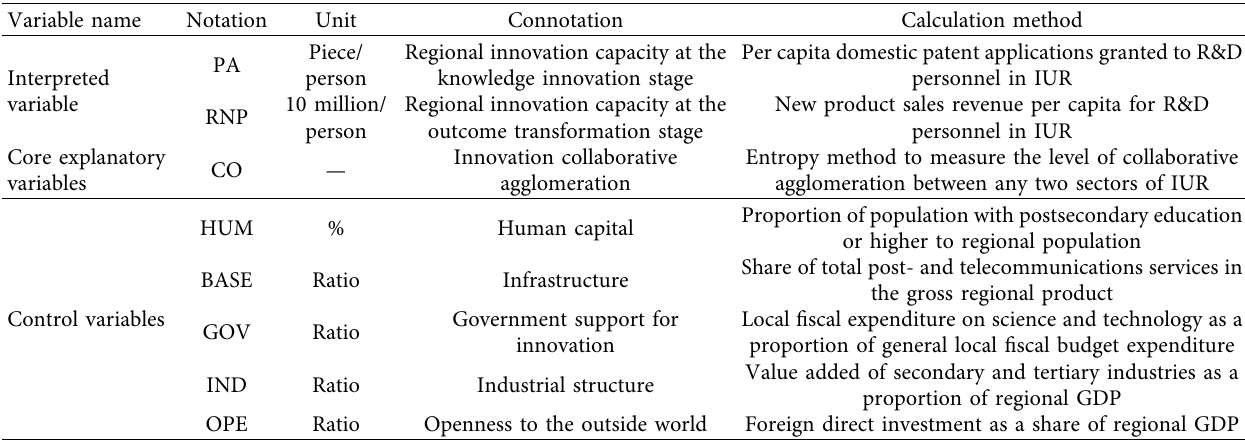
Table 2: Qualitative description of variables.